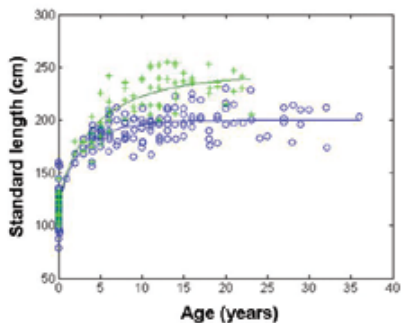
Fig. 2. Growth in standard length with age of female (o) and male (+) Icelandic grey seals (Halichoerus grypus) described with the von Bertalanffy model (see McLaren 1993).